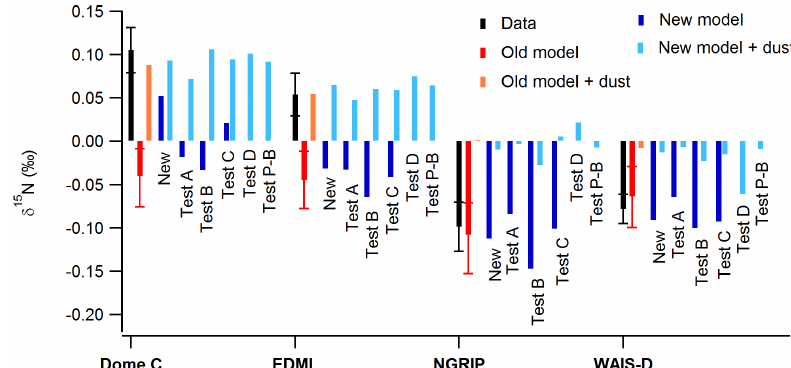
Figure 7. Difference between EH and LGM δ 15 N at four different polar sites (raw data are given in Table S4). The measured δ 15 N dif- ference is shown by a black bar (data). The modelled δ 15 N difference is shown with colours: old version in red (orange with the impurity influence), new version in blue with different parameterizations. “New” corresponds to the parameterization in Table 1. Parameterizations for sensitivity tests A, B, C, and D are given in Table 3. When “ + dust” is mentioned, it corresponds to the addition of the impurity influence as parameterized by Freitag et al. (2013) (Eqs. 8 and 9). Test Pimienta–Barnola (P–B) corresponds to a test with implementation of the impurity effect in the “New” parameterization following the Freitag parameterization adapted to the Pimienta–Barnola model instead of the Herron and Langway model used for the other sensitivity tests. We display the modelled error bars only on the old model outputs (red) but the same uncertainty can be applied to all model outputs (New; Tests A, B, C, and D; and P–B) at each